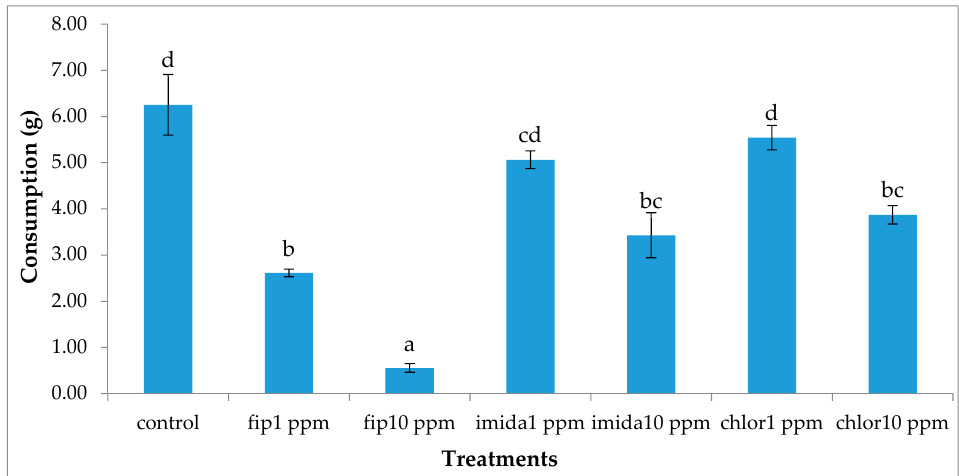
Figure 6. Mean total food (top wood, top cardboard, ramp and bottom wood) consumption (±SEM) after one month (12 days for fip10 ppm) of treatment. Means with the same letters are not significantly different ( p > 0.05) using Tukey’s HSD means separation.